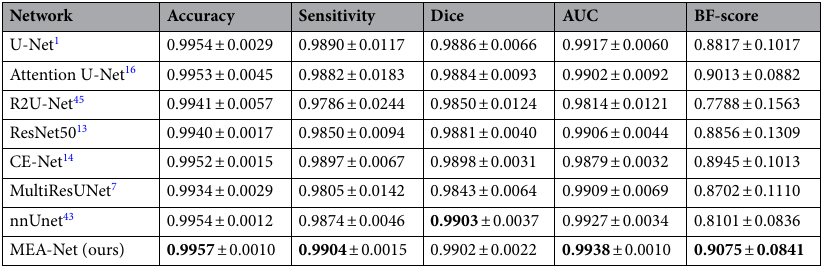
Table 1. Performance comparison on tongue segmentation (mean ± standard deviation). Significant values are in